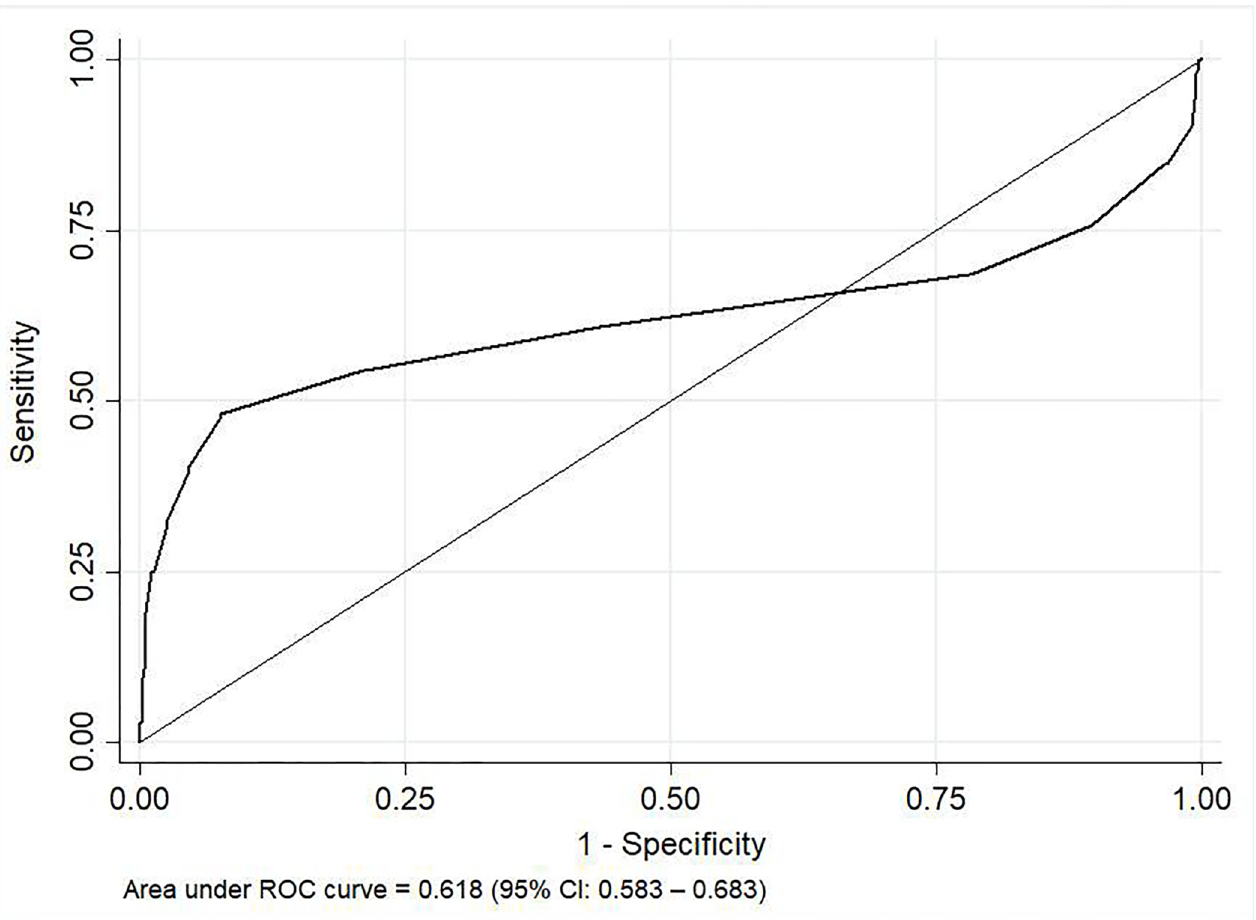
Fig 4. ROC showing the ability of CR in correctly differentiating eyes with refractive error ( > 0.5D) from eyes without refractive error.